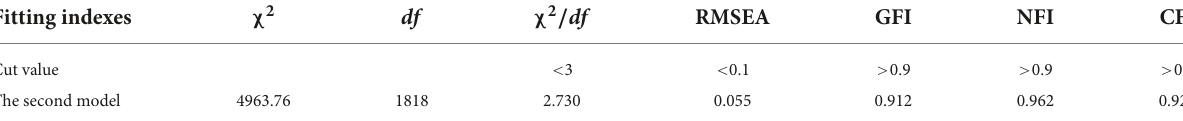
TABLE 4 Model fit